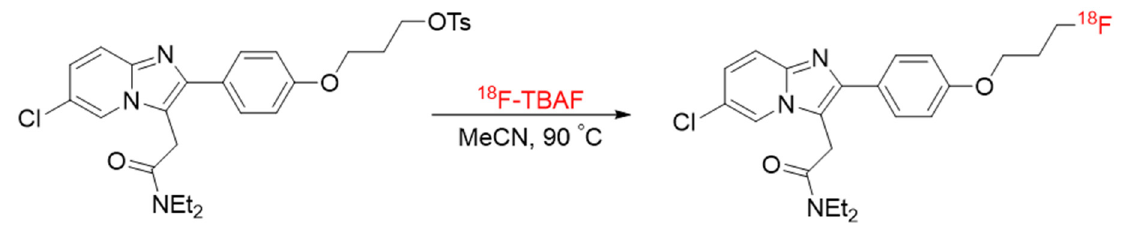
Figure 1. Chemical diagram of radiosynthesis of 18 F-PBR-111.